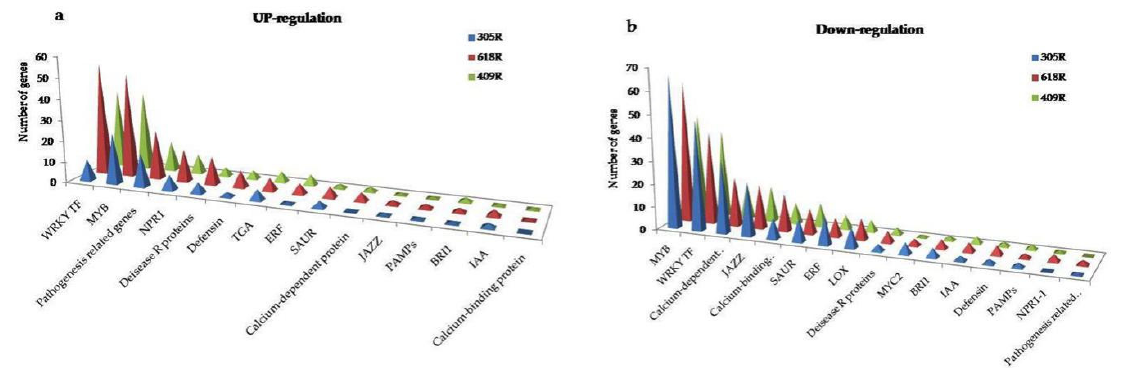
Figure 4. Comparative identification of DEGs related to the plant–pathogen interaction, plant hormonal signal transduction, and transcription factors in the pyramided and parental lines. ( a ) Up-regulation. ( b ) Down-regulation.